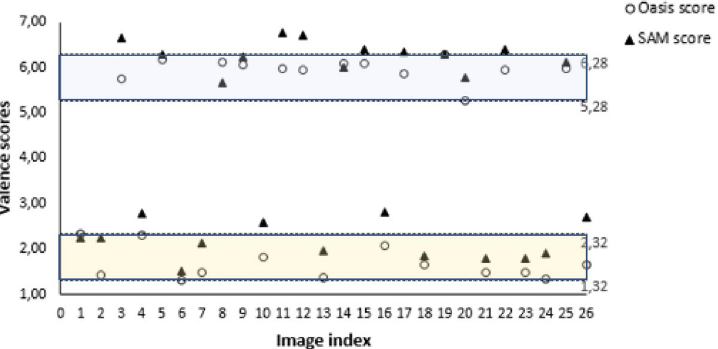
Figure 3. Oasis valence score and SAM average scores of the 26 images selected for the experiments. The Oasis score intervals used to extract polarized images are identified by dotted lines.